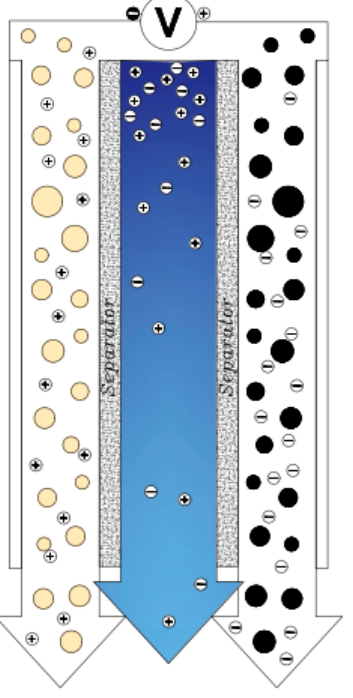
Figure 8. Flow Capacitive Deionization electrodes in CDI cell.